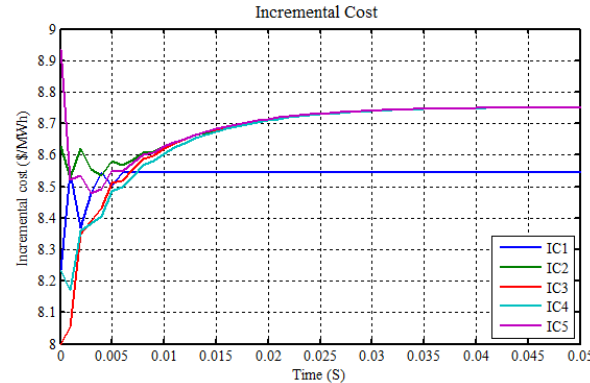
Figure 5. Case study 2: the incremental cost of the five generators.